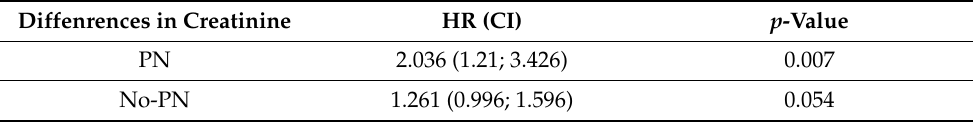
HR = Hazard Ratio; CI = 95% Confidence